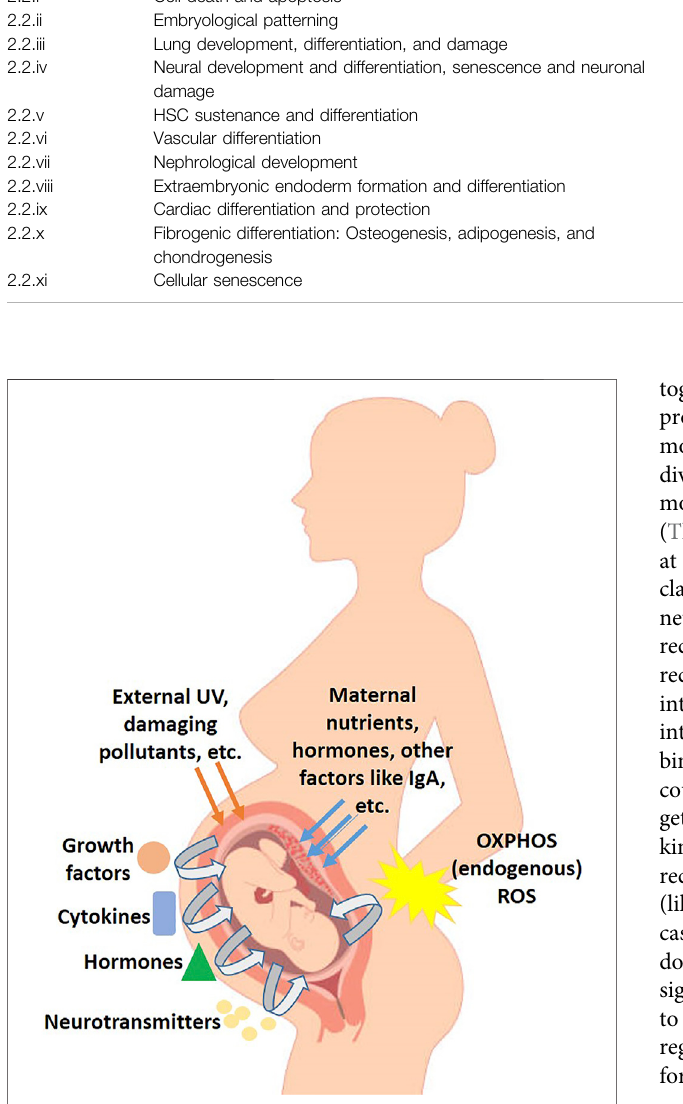
FIGURE 1 | Schematic diagram of the various factors and signaling involved in development of the embryo in utero .